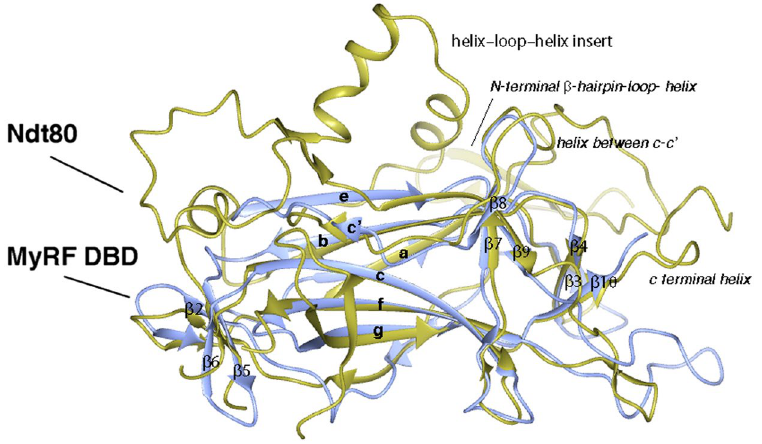
Figure 2. The superimposed structures of MyRF DBD and Ndt80 (PDB code: 1MNN) colored in ice blue and gold respectively. The figure was generated using CCP4gm